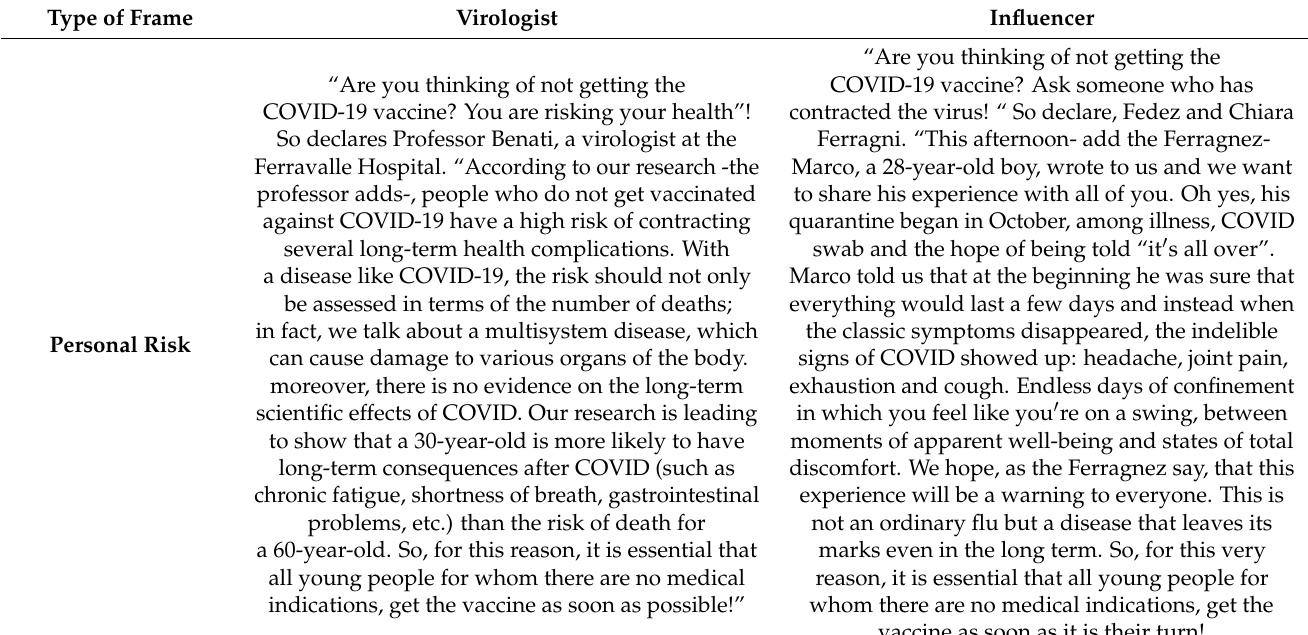
Table 1. Message frames administered in the study